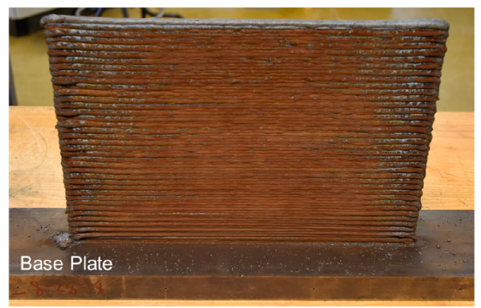
Figure 3. One of the MBAAM manufactured test walls.